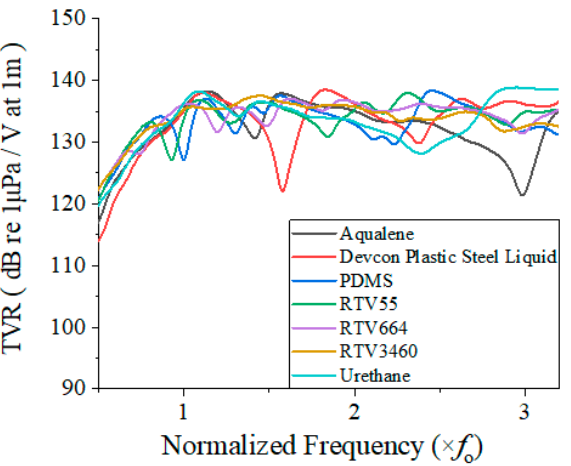
Figure 6. TVR spectra of the array potted with rubber materials. Table 5. Acoustic characteristics of the array potted with RTV materials.